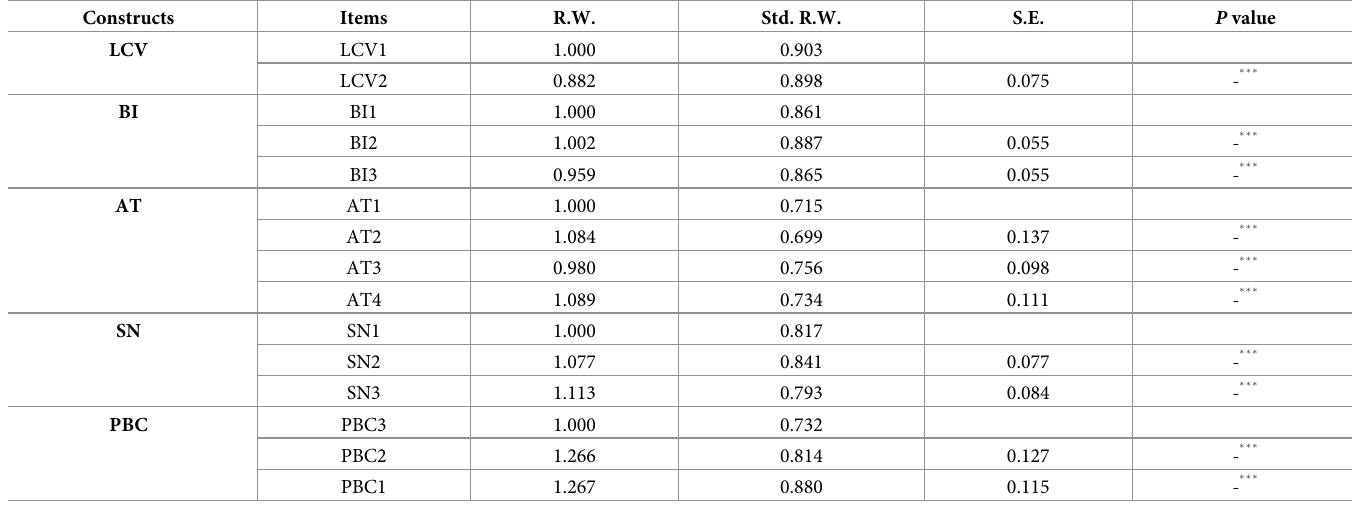
between attitude, subjective norms and PBC. Therefore, hypothesis H1 is supported. Table 10. Estimation results of CFA ( N = 253).